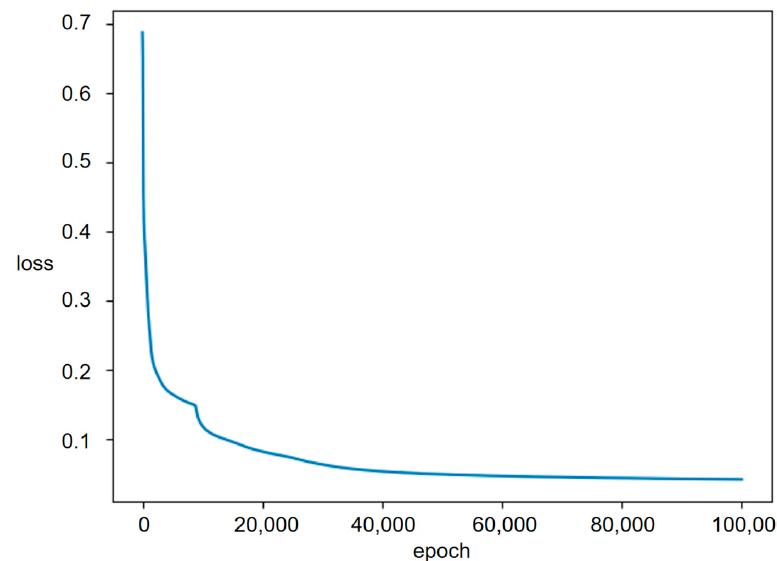
Figure 13. Change in the loss value during DLNet training.